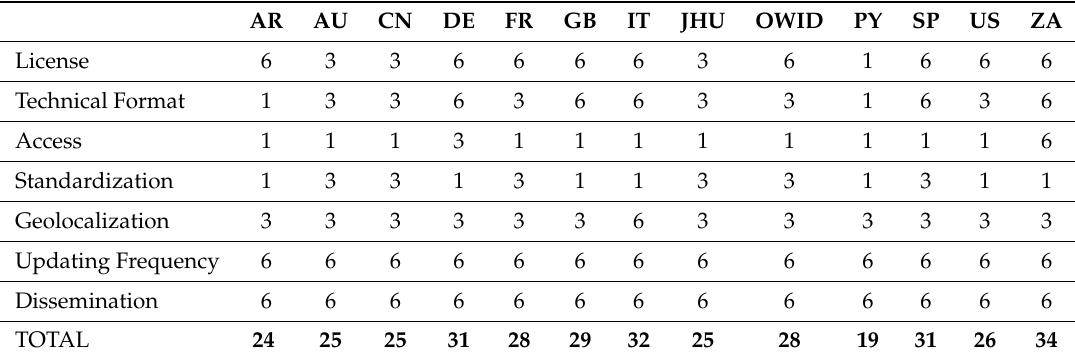
Table 2. Total score corresponding to the first 7 reusability dimensions of MELODA 5 for different